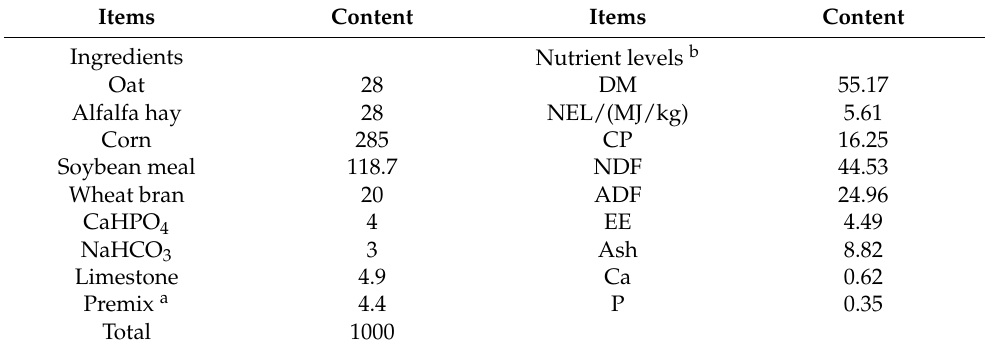
Table 1. Chemical composition and nutrient levels of the basal diets (g/kg, DM